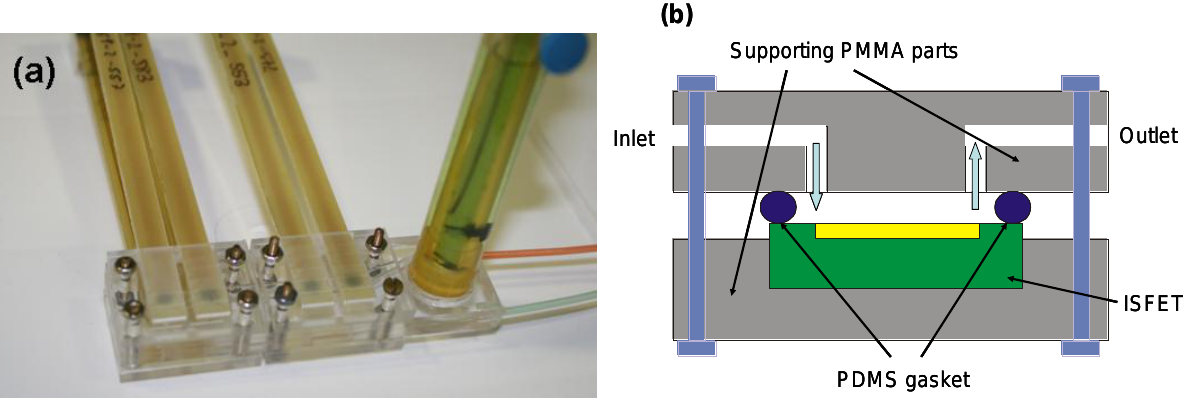
Figure 1. ( a ) Picture of the flow cell employed for the ISFETs measurements and ( b ) a detailed scheme of an ISFET